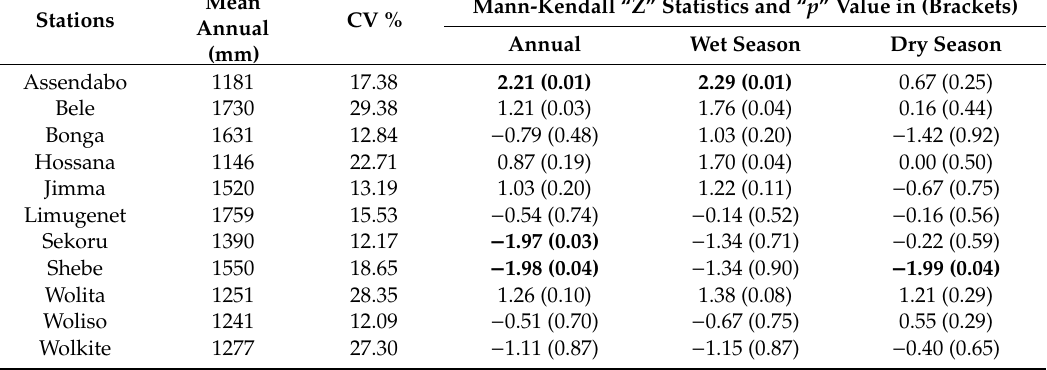
Table 3. Results of Mann-Kendall test for annual and seasonal rainfall at eleven stations, bold numbers indicate statistical significant trends at 0.05 level. Positive/negative Z value indicates increasing and decreasing trend, respectively.